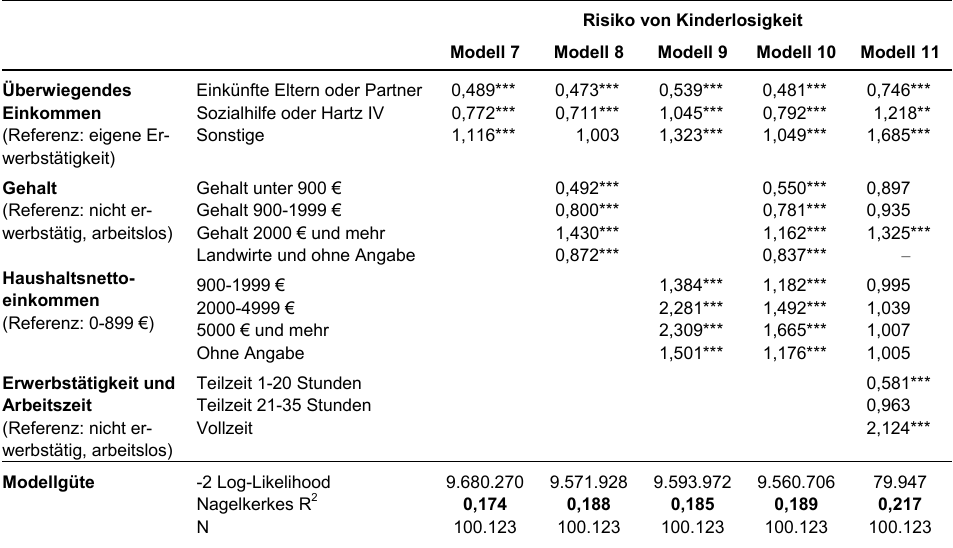
Tabelle 4 : Logistische Regression, Odds Ratios,